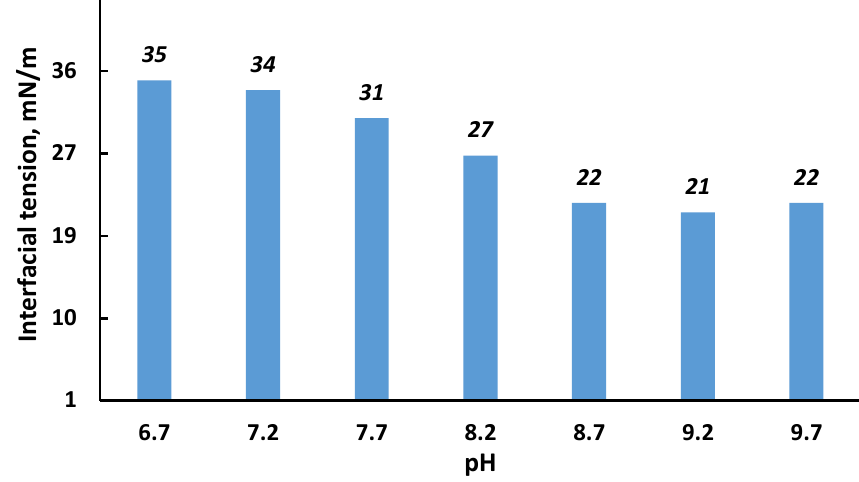
Figure 12. Influence of pH on the initial interfacial tension of the saline water – crude oil interface.